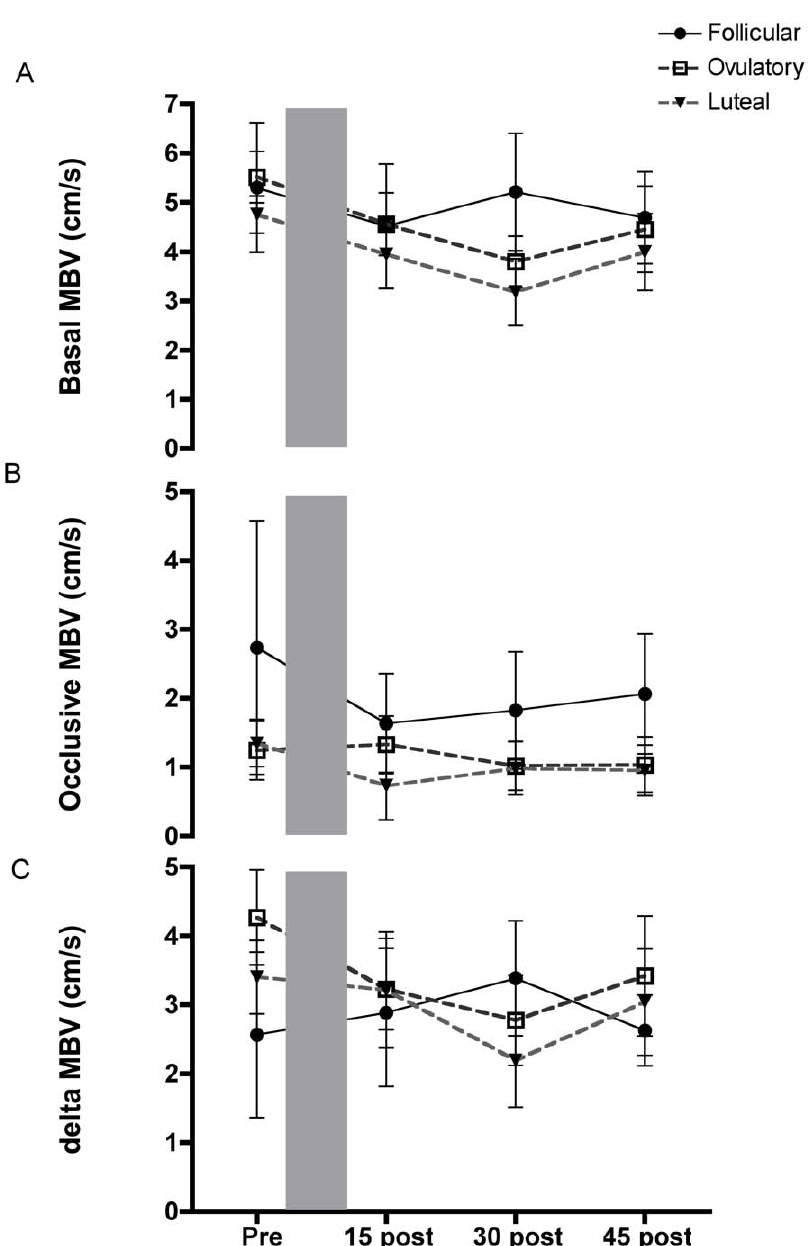
Figure 4. Basal and distal occlusive brachial artery shear. a–b) basal brachial mean blood velocity and brachial mean blood velocity measured when distal occlusion was applied was not altered by prolonged low flow (shaded area). c) Change in mean blood velocity upon cuff inflation was unaltered. MBV is the mean blood velocity.